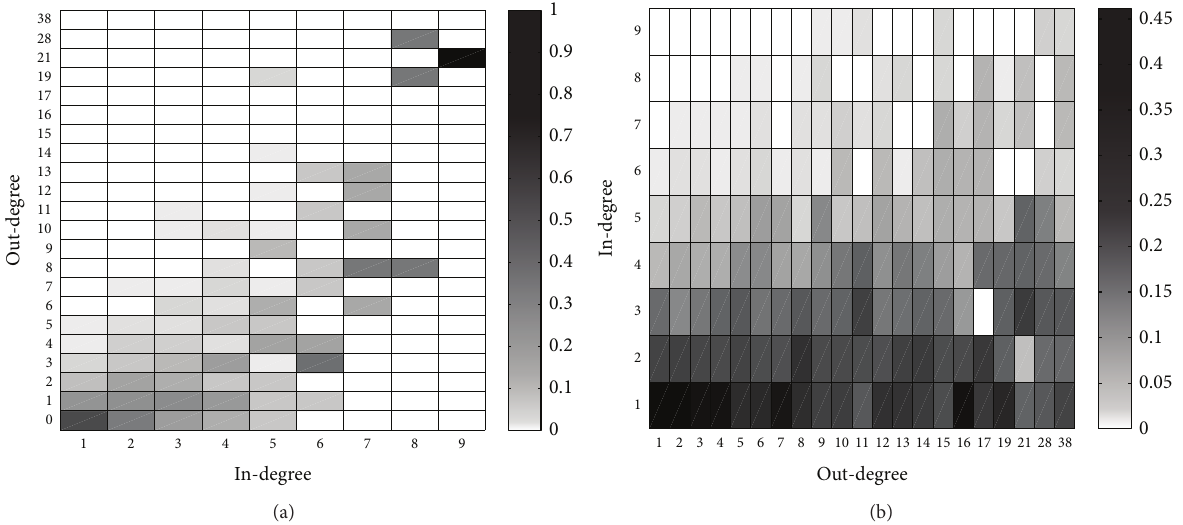
Figure 6: Degree correlations. (a) Degree correlations at users. Columns indicate the distributions of out-degrees for users with given in- degrees. (b) Degree correlations at links. Columns indicate the distributions of followers’ in-degrees for users with given out-degrees.